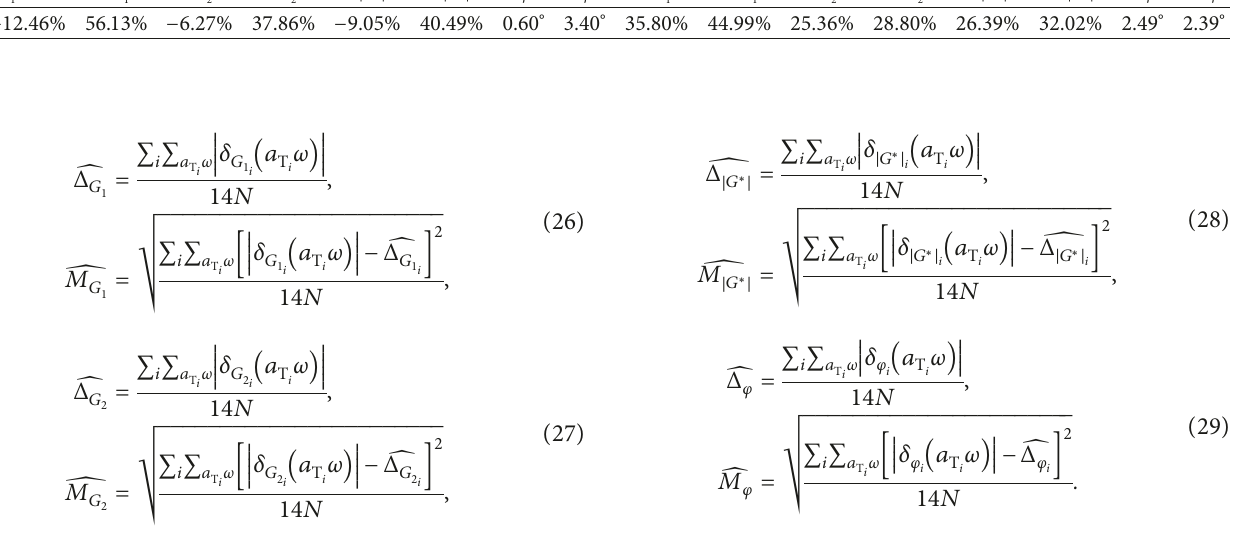
Table 2: Overall global errors of 2S2P1D model fitting for a bitumen, calculated for the whole calibration panel according to equations